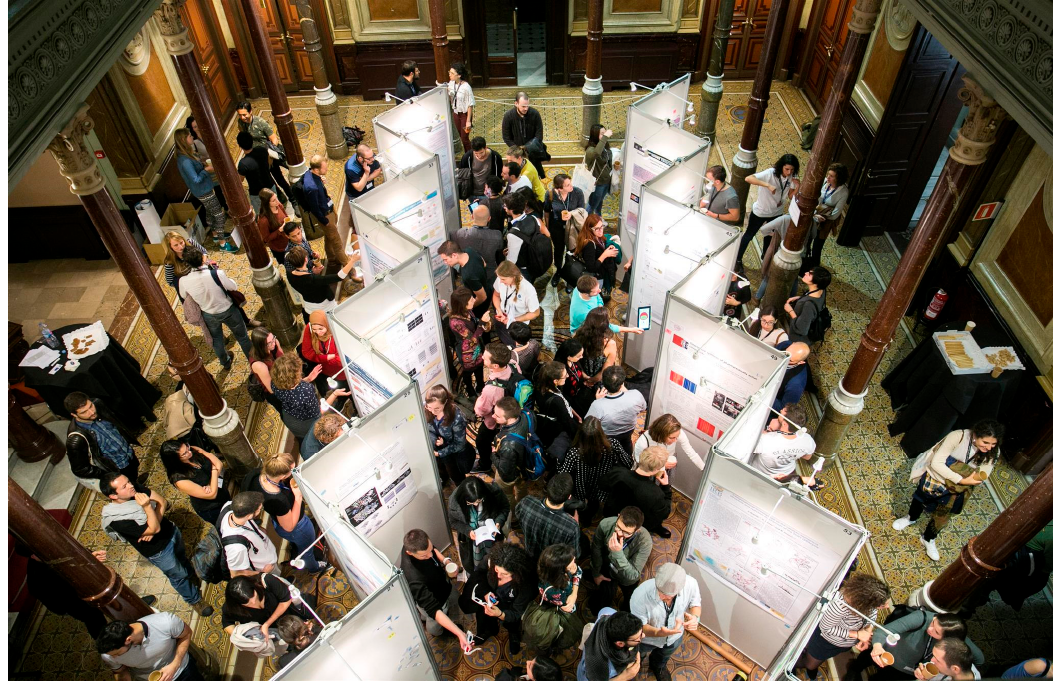
Figure 1. Ongoing vibrant discussions of our participants during the poster session.